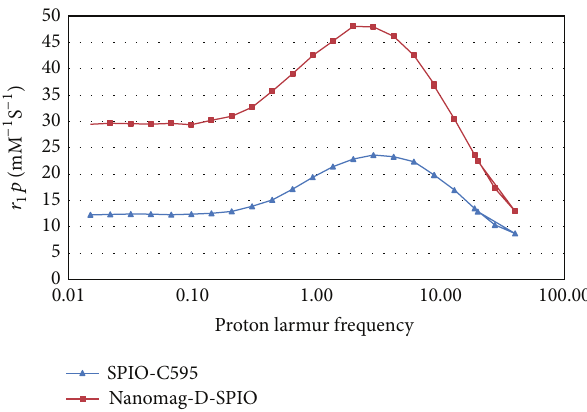
Figure 1: NMRD profile of Nanomag-D-SPIO and synthesized nanoparticle (SPIONs-C595) probe.